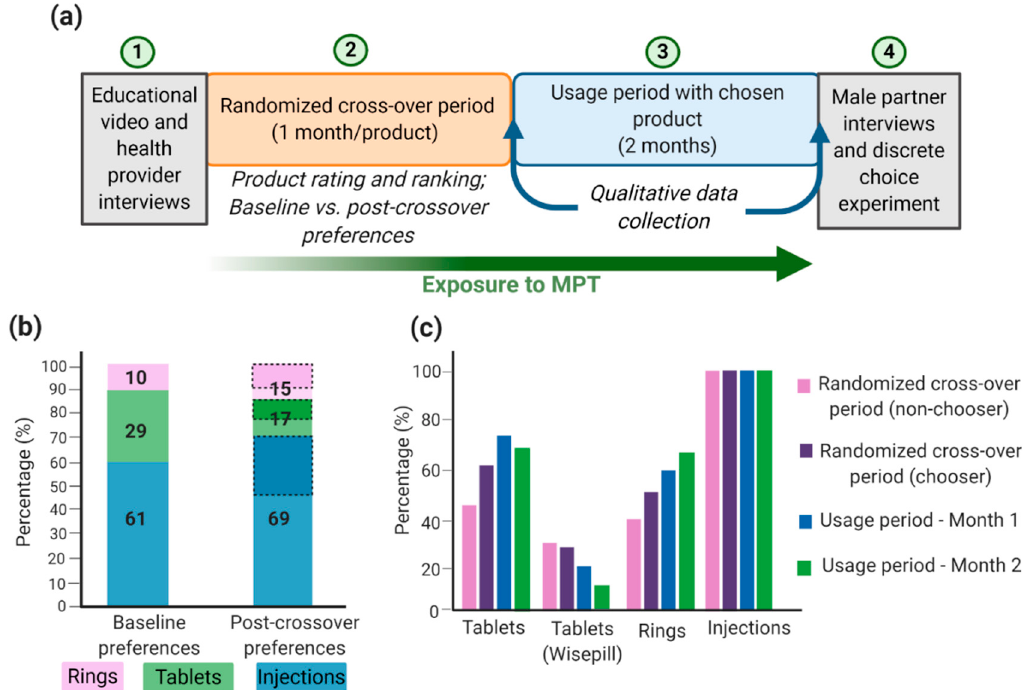
Figure 3. TRIO implementation study design and outcomes: ( a ) TRIO study design; ( b ) women acceptability (%) toward MPTs and shift in preferences from baseline to post-crossover period. Baseline preference is the participant’s choice before trying all products. Post-crossover preference is the participant’s choice after trying all products and the product the woman will use during the two-month usage period. Dashed sections in the post-crossover preferences represent women who had a different preferred product at baseline; ( c ) Product adherence (%) during the study. For tablets, Wisepill containers were used to electronically track the opening of the container and to obtain objective adherence data. Image recreated with permission from [134,136]. Figure created with BioRender.com, accessed on 12 October 2020.